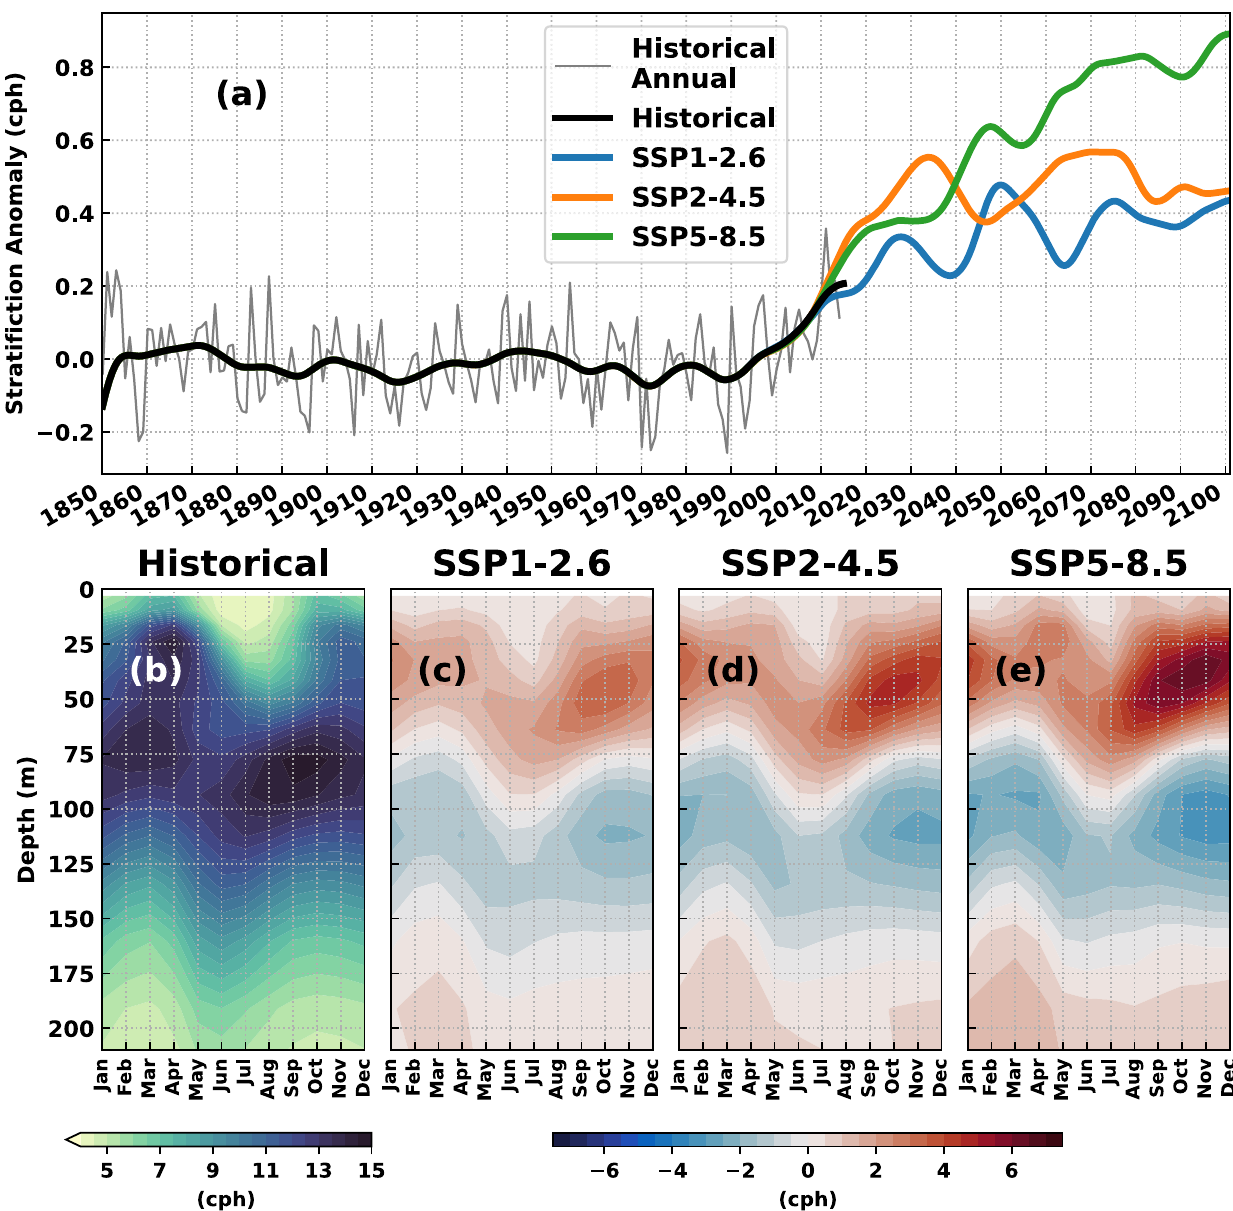
Fig. 2 Temporal changes in the Andaman Sea strati fi cation. a Time series of Andaman Sea annual (grey) and 20-year low-pass fi ltered depth-averaged strati fi cation anomalies relative to 1850 – 2014 mean derived from Historical (black), SSP1-2.6 (blue), SSP2-4.5 (orange), and SSP5-8.5 (green). b Annual cycle of the Andaman Sea strati fi cation in Historical simulation. Annual cycle of strati fi cation anomalies in ( c ) SSP1-2.6, d SSP2-4.5, and ( e ) SSP5- 8.5 simulations relative to the annual cycle of Historical simulation. The Andaman Sea is represented by domain-averaged (4 – 17°N, 91.5 – 99°E) values (white box in Fig. 1b) derived from